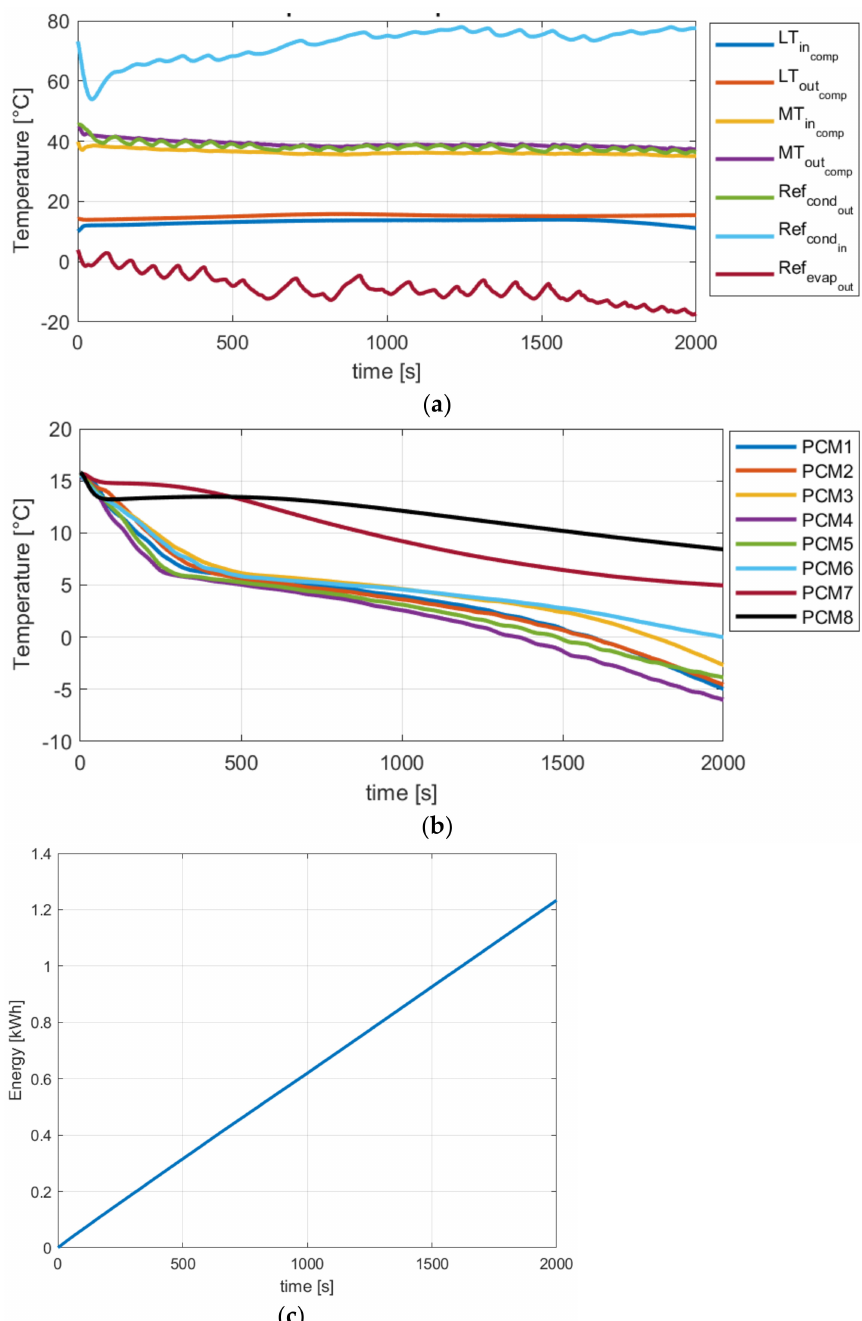
Figure 5. Example of test results for charging mode 1. ( a ) Temperatures of HTF and refrigerant circuits of the RPW-HEX; ( b ) temperatures of the PCM; ( c ) energy supplied to the PCM during the test. For the charging operation of the RPW-HEX, the main peculiarities identified were the extremely high temperature difference between the refrigerant at the compressor outlet and the evaporator outlet, which penalizes the operation of the system. The spikes in the temperature evolutions of the refrigerant were due to the operation of the thermostatic expansion valve. In order to better understand the temperature distribution in the RPW- HEX, the schematic of the latent storage and the positions of the sensors are shown in Figure 4. It was possible to notice that, during charge of the RPW-HEX, the areas close to the refrigerant outlet (PCM4, PCM5) were the coldest one. Moreover, there was a stratification in the vertical direction, with the upper part of the HEX (PCM7, PCM8) at a